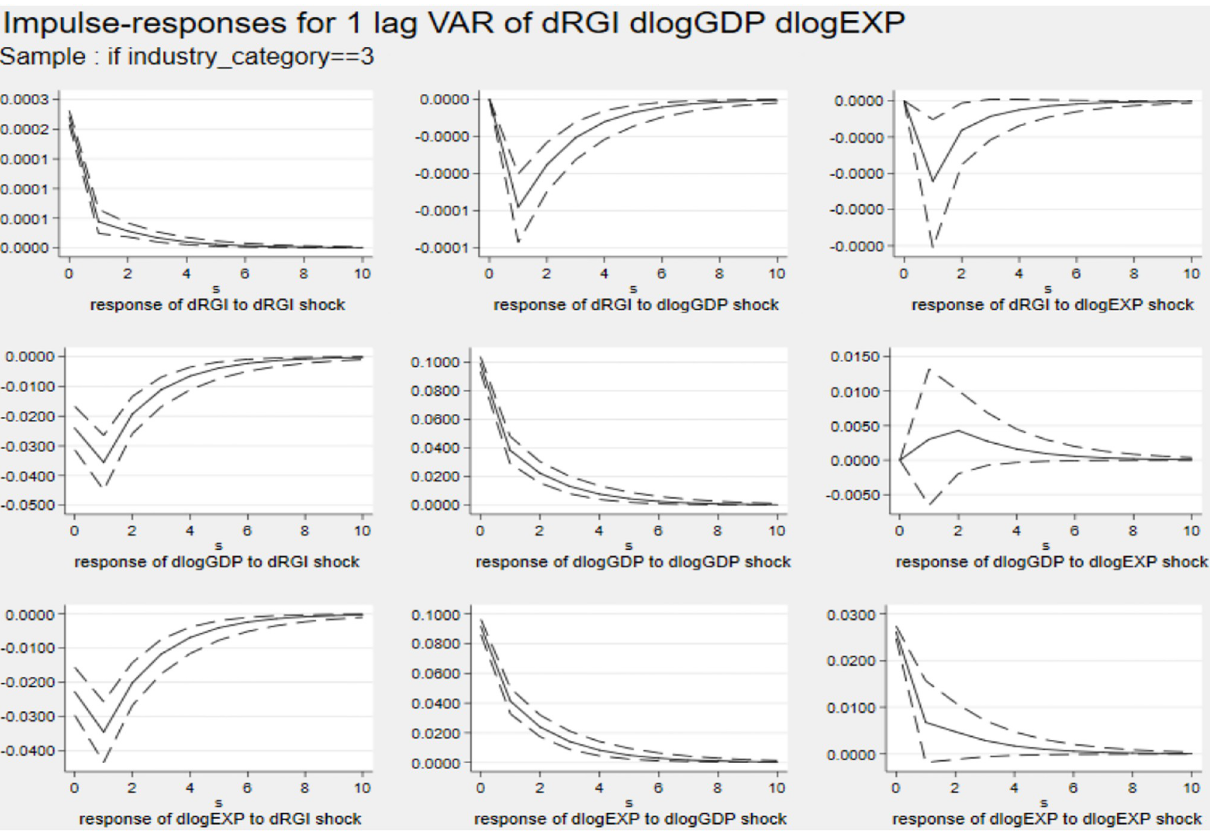
Fig 8. Impulse response diagram in Cluster 7. Notes : Errors are 5% on each side generated by Monte-Carlo with 2000 reps.